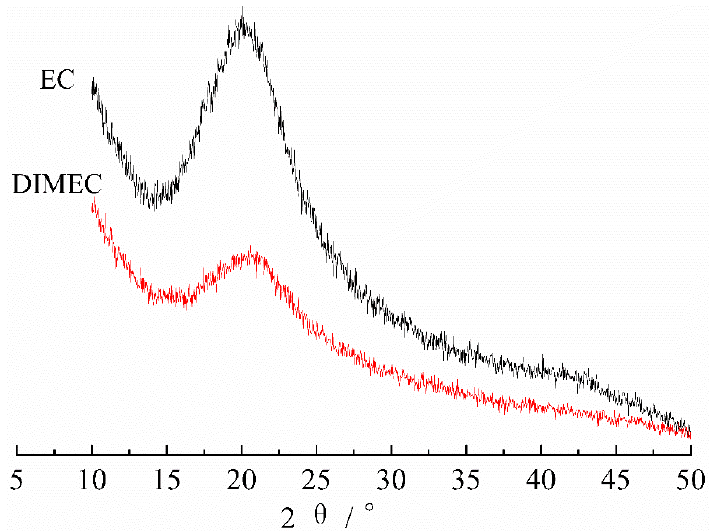
Figure 5. XRD of DIMEC and EC.